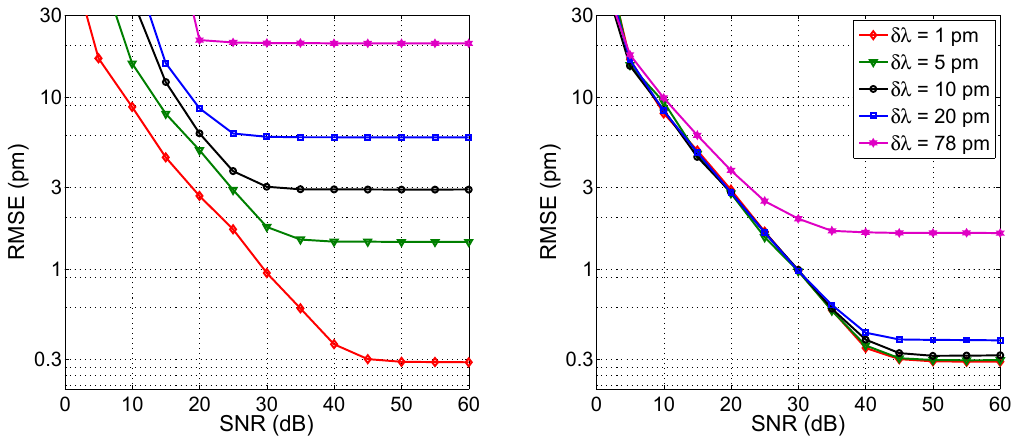
Figure 23. Performance analysis of correlation-based tracking technique: the RMSE on peak detection is reported as a function of SNR, for different values of sampling grid δλ (1 pm, 5 pm, 10 pm, 20 pm, 78 pm). ( Left ) FBG spectra are processed without resampling. ( Right ) FBG spectra have been resampled, on a new grid with δλ R = 1 pm.